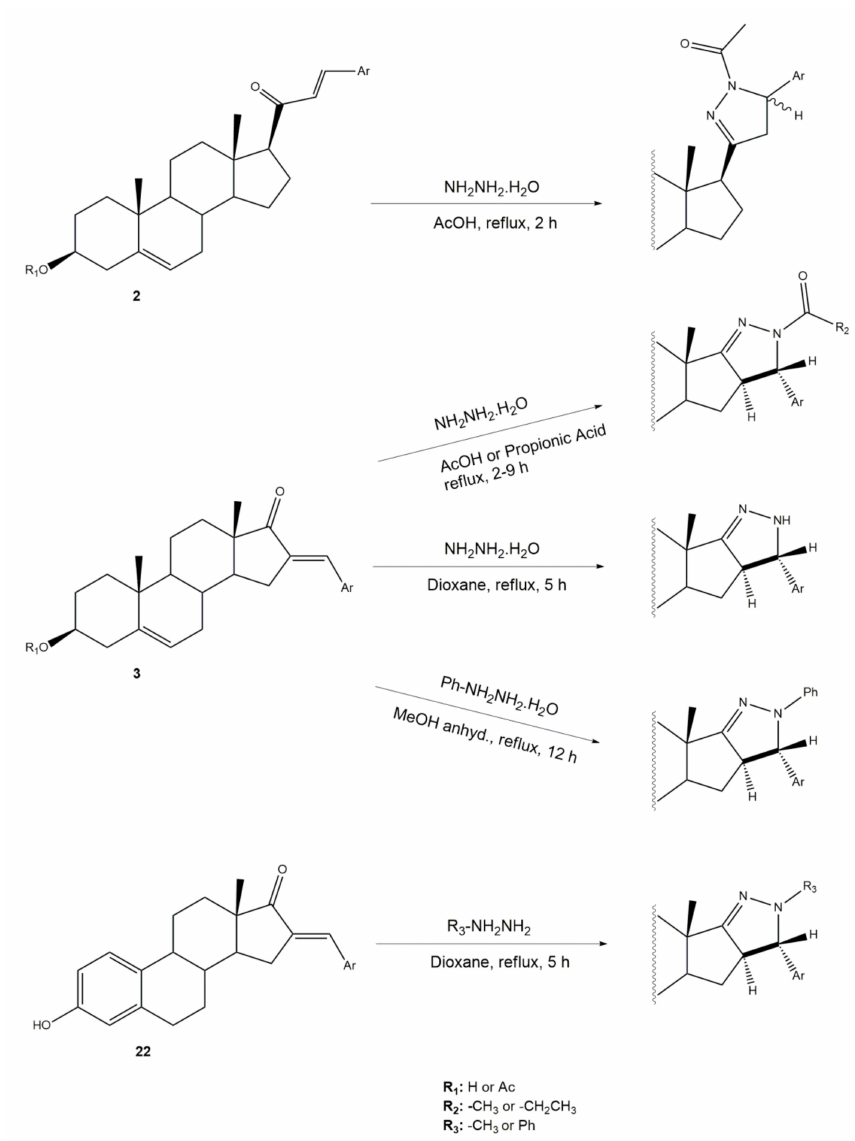
Figure 5. Synthesis of steroidal arylpyrazolines from 16 E - and 21 E -arylidenesteroids. The synthesis of steroidal arylpyrimidines and pyridines from 16 E- and 21 E -arylidene- steroids was also described (Figure 6). In fact, Ke et al. described the preparation of steroidal[17,16- d ]pyrimidines using 3 as starting material and guanidine nitrate under basic catalysis and reflux during 1 h [49]. In addition, Huang et al. reported the synthesis of steroidal[17,16- d ]triazolopyrimidines using 3-aminotriazole, again using a basic catalyst at reflux during 30 h [41]. Furthermore, 2’-aminopyrimidines and 2’-cyanoiminopyrimidines were prepared from 16 E -arylidenoestrone derivatives using guanidine hydrochloride or 2-cyanoguanidine and sodium ethoxide in EtOH, and the mixture was refluxed for 4– 6 h [102]. Different steroidal pyridines were also synthesized from 21 E -arylidenesteroids in the presence of malononitrile and sodium ethoxide, at reflux temperature for 8 h, in a single reaction. Interestingly, sodium ethoxide acted as a bifunctional species, being simultaneously the ethoxy source and the promoter of reactions between α , β -unsaturated ketones and malononitrile